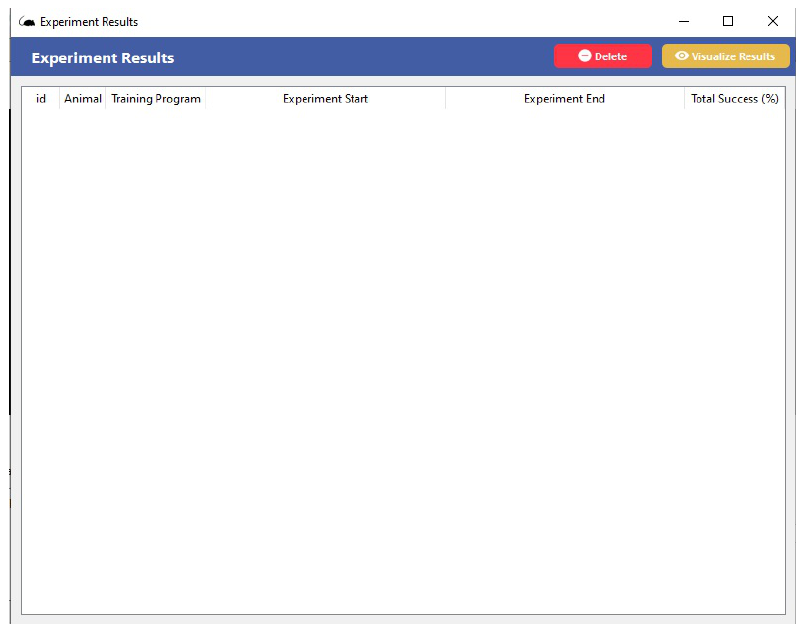
Figure 9. Function screen Results of the supervisory software of the behavioral